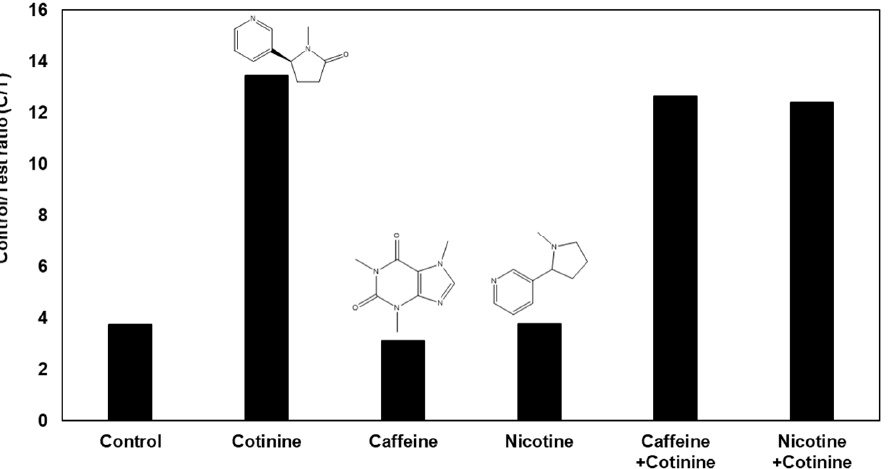
Figure 6. Selectivity test with 100 ng/mL cotinine along with 100-times caffeine and nicotine in the gap ‐ LFIA.